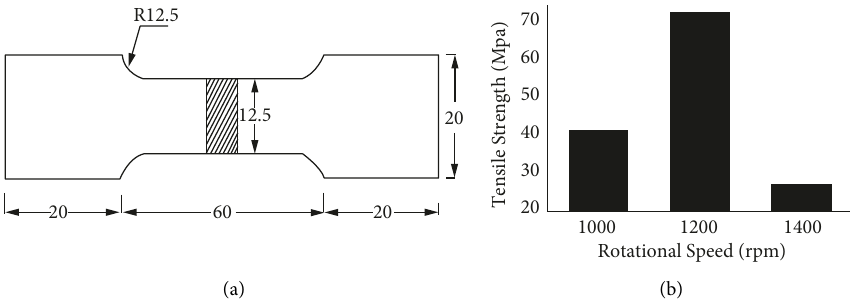
Figure 11: (a) The dimensions of tensile test specimen, (b) tensile strength of Cu-Br welded joint at various rotational speeds.